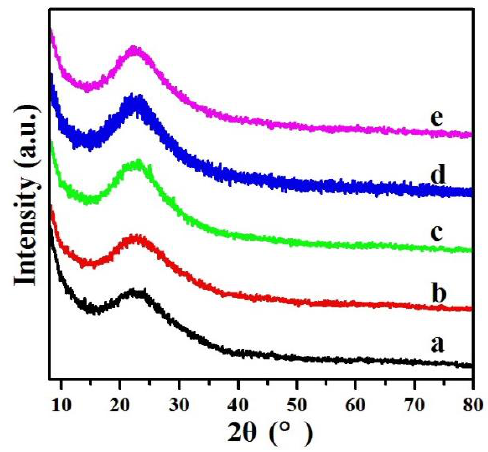
Figure 3. Wide-angle XRD patterns of (a) SBA-15, (b) 0.2%Pd/SBA-15, (c) 0.2%Pd-0.4%Ni/SBA-15, (d) 0.2%Pd-0.7%Ni/SBA-15, (e) 0.2%Pd-1.2%Ni/SBA-15.